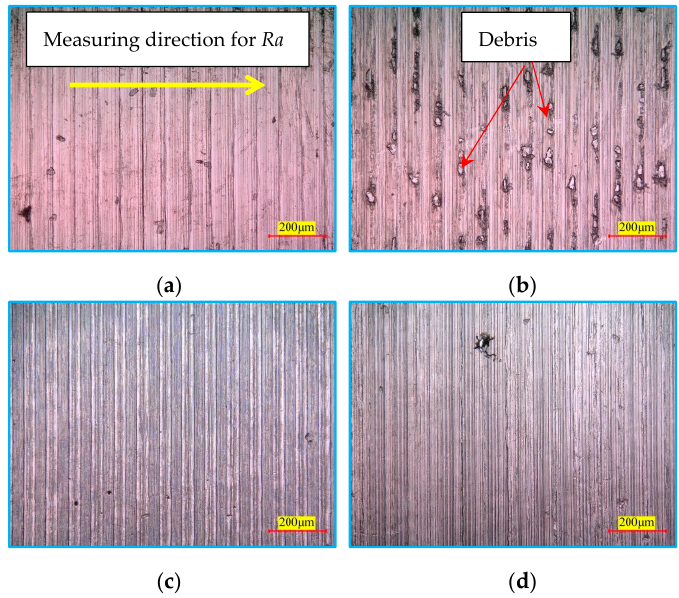
Figure 8. Surface topography of finish-machined SLMed 316L stainless steel ( f = 0.08 mm/rev). ( a ) V c = 50 m/min; ( b ) V c = 100 m/min; ( c ) V c = 150 m/min; ( d ) V c = 200 m/min.